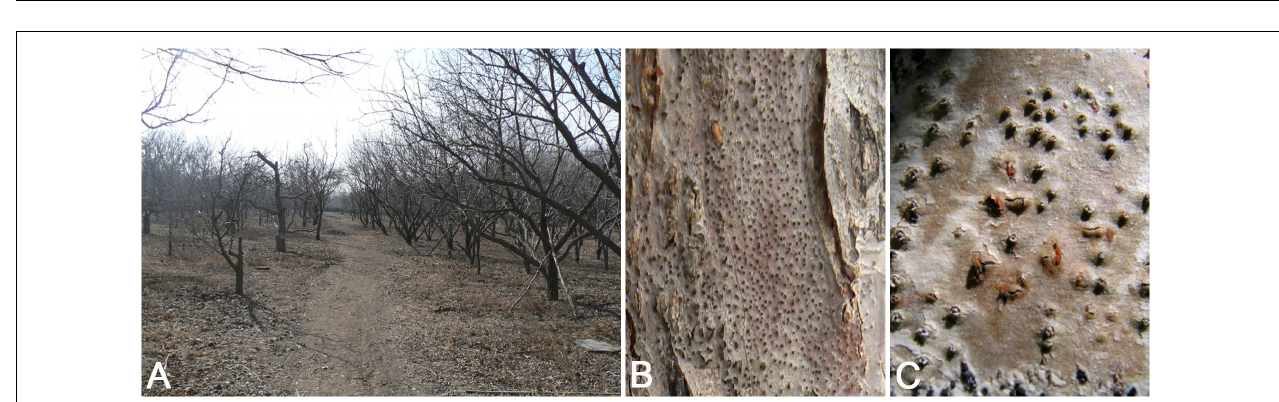
FIGURE 2 | Disease symptoms associated with Cytospora species on Malus sp. (A) Death of the apple trees caused by Cytospora in the orchards. (B,C) Conidiomata on a naturally infected stem in the field.